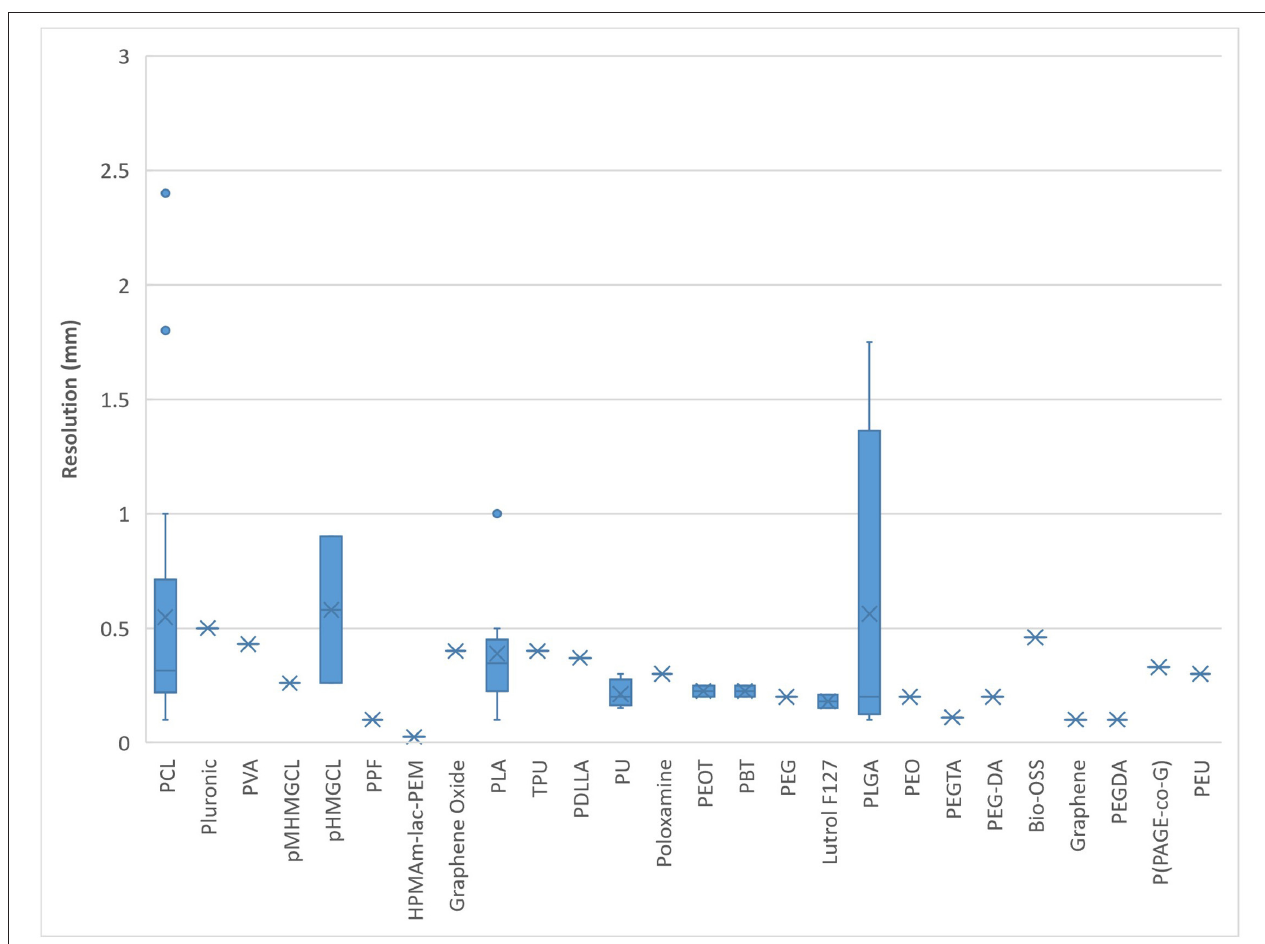
FIGURE 6 | Bioprinting resolution for synthetic-derived